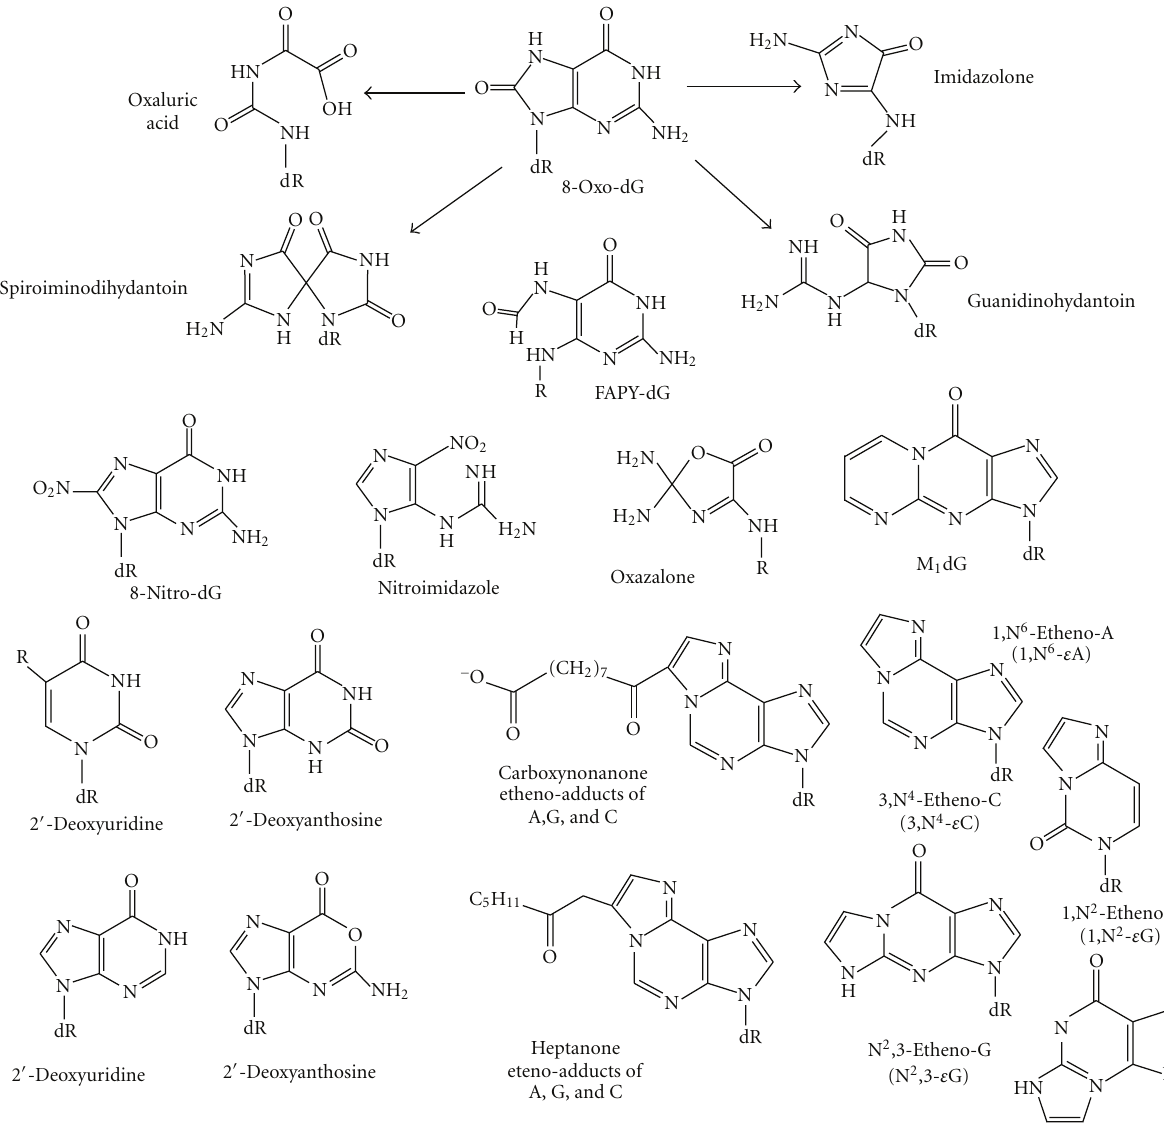
Figure 1: Nucleobase damage